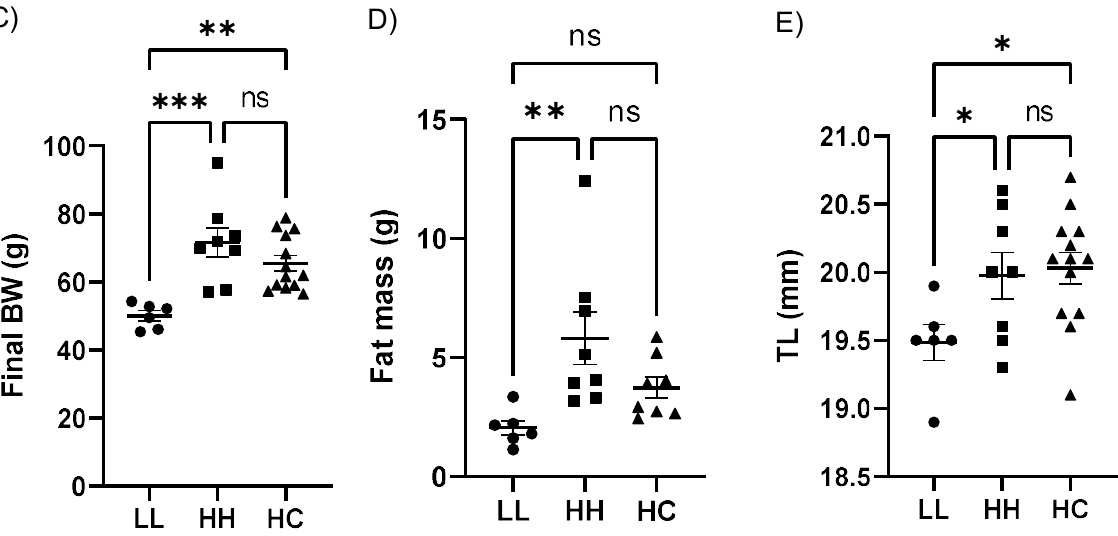
Figure 1. Physical characteristics. ( A ) BW at weaning; ( B ) BW trend over time; ( C ) Final BW; ( D ) Fat mass; and ( E ) TL in LL, HH, and HC mice. BW, Body weight; TL, Tibial length; HFHS, a high-fat and a high-sucrose diet; LFLS, a low-fat and a low-sucrose diet; LL, offspring born from maternal LFLS and postnatal LFLS indicated by closed circles (●); HH, maternal HFHS and postnatal HFHS indicated by closed squares ( ■ ); HC, maternal HFHS weaned onto a standard laboratory chow diet indicated by a closed triangle ( ▲ ). Values are expressed as mean ± SEM. * p < 0.05; ** p < 0.01; *** p < 0.001; ns, not significant. n = 6 in LL; n = 8 in HH; and n = 8–13 in HC.